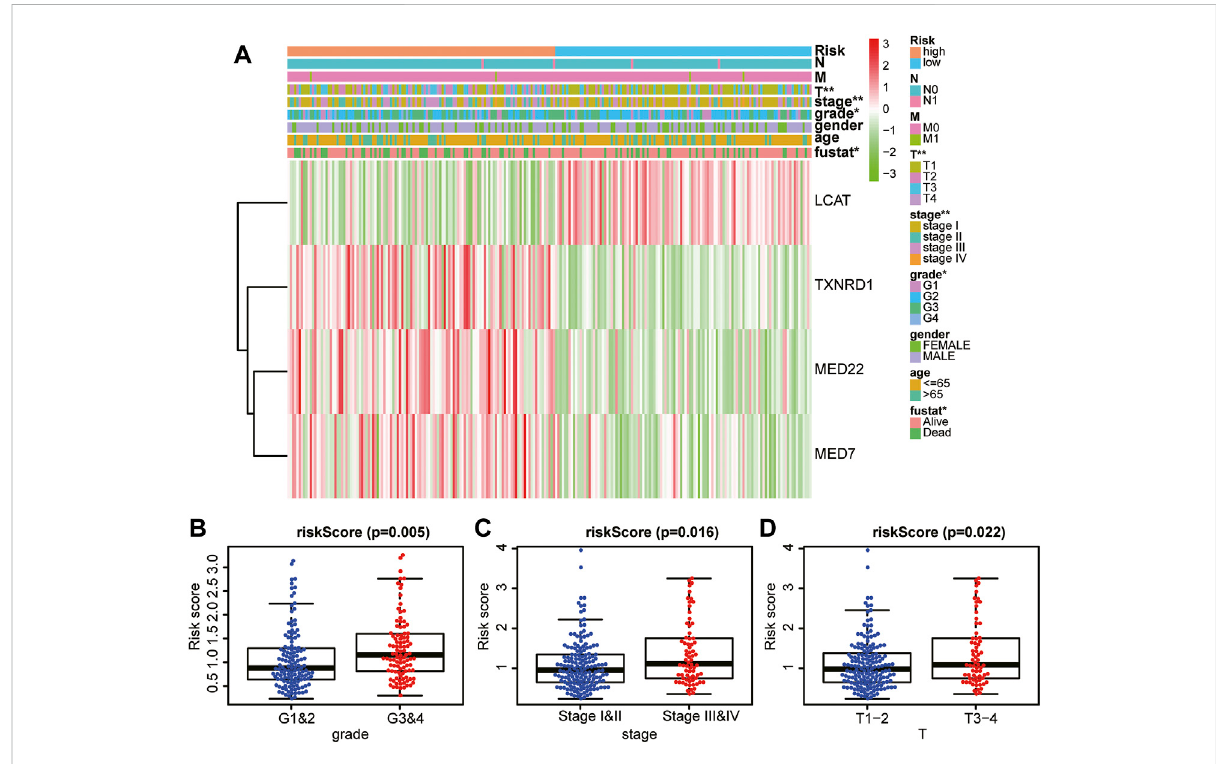
FIGURE 6 Prognostic risk score correlated with clinicopathological characteristics. (A) Heatmap of clinicopathological characteristics and different lipid metabolism-associated gene expression levels in high/low-risk groups. (B – D) Comparison of risk score distribution in the different sample classi fi cation of tumor grade (B) , tumor stage (C) and T staging (D)